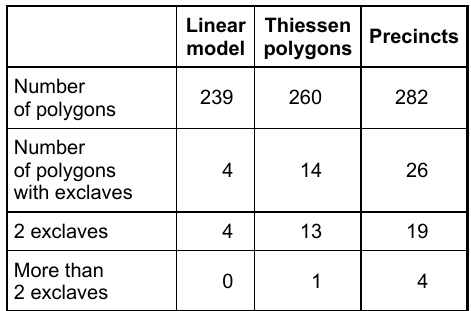
Table 1. Number of polygons according to analysed